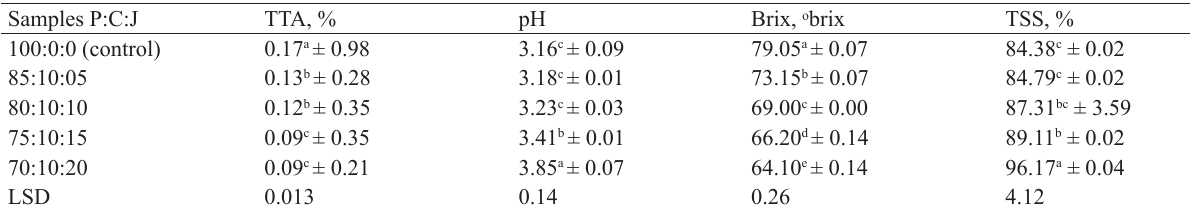
Table 3 TTA, pH, Brix, and TSS of jam from cucumber, pineapple and, Jatropha leaf in different proportions Samples